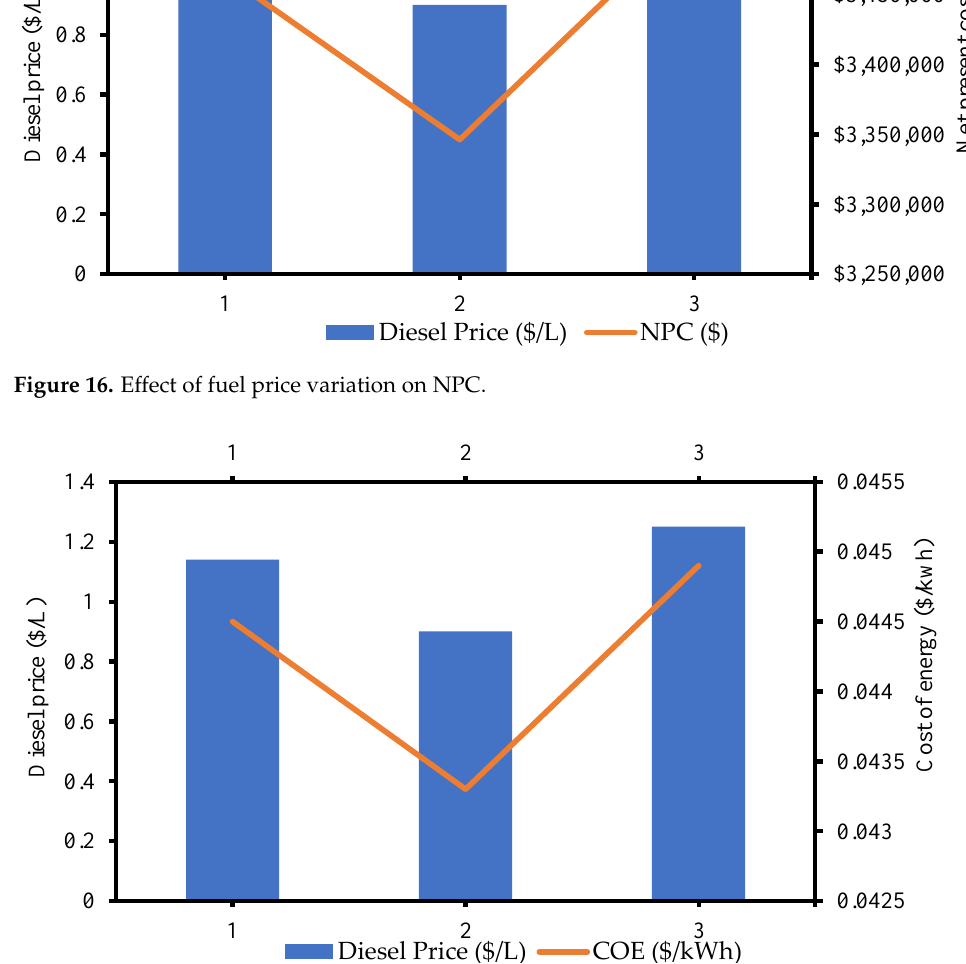
Figure 17. Effect of fuel price variation on COE.